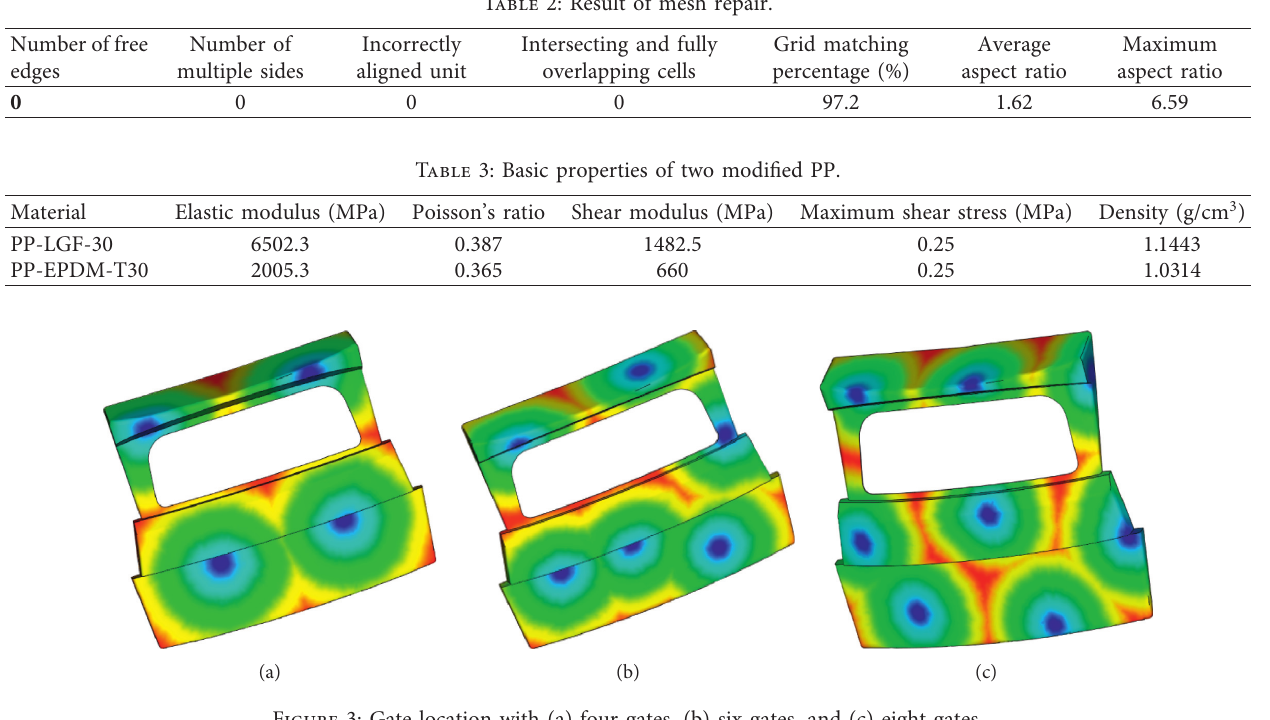
Figure 3: Gate location with (a) four gates, (b) six gates, and (c) eight gates.